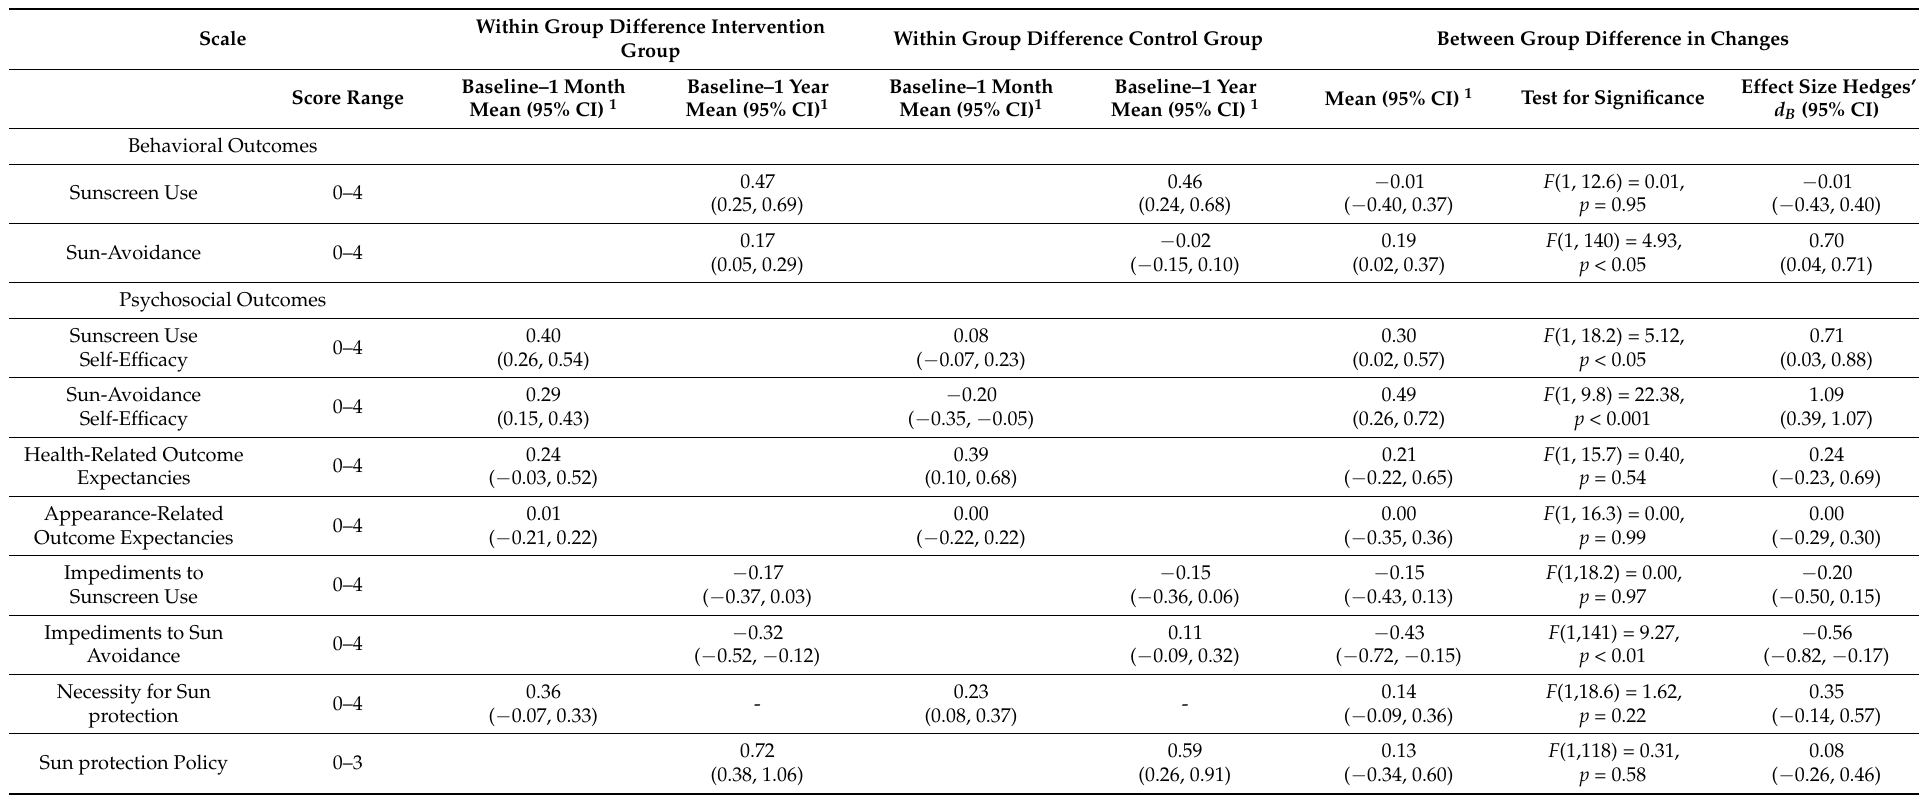
Table 5. Changes in behavioral and psychosocial outcomes and Sun Protection Policy scores after 1 month and 1